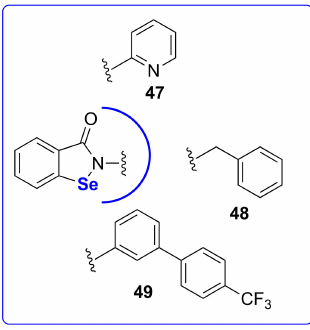
Figure 13. SOD1 Cys111